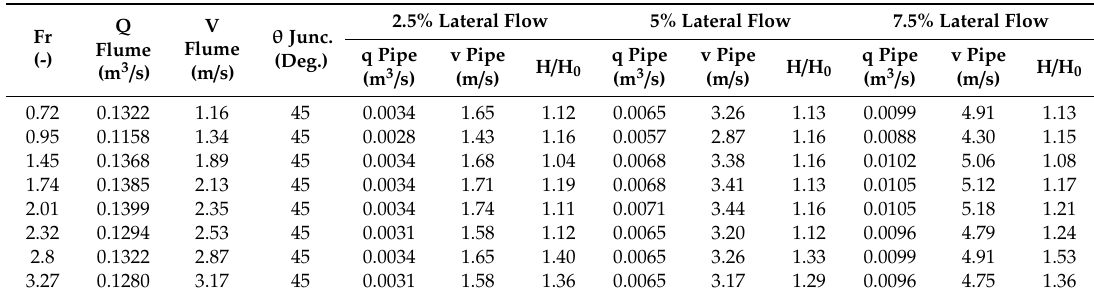
Table 6. Experimental results for the 45 ◦ junction in the narrow